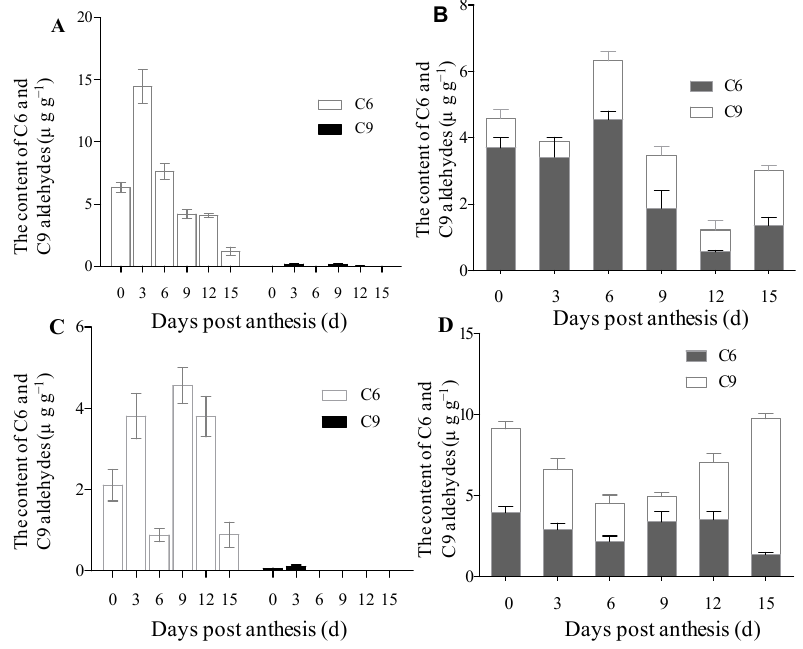
Figure 5. C6 and C9 aldehyde contents produced by crude enzyme extracts from cucumber fruit at different development stages using HPOD as substrate. ( A ) C6 and C9 aldehyde contents produced using 13-HPOD as a substrate during cucumber fruit development in No. 26; ( B ) C6 and C9 aldehyde contents produced using 13-HPOD and 9-HPOD mixture as a substrate during cucumber fruit development in No. 26; ( C ) C6 and C9 aldehyde contents produced using 13-HPOD as substrate during cucumber fruit development in No. 14-1; and ( D ) C6 and C9 aldehyde contents produced using 13-HPOD and 9-HPOD mixture as substrate during cucumber fruit development in No. 14-1. Y axis represents C6 and C9 aldehydes contents. Data represent the means ± SD of three biological replicates (three fruits were taken as a biological